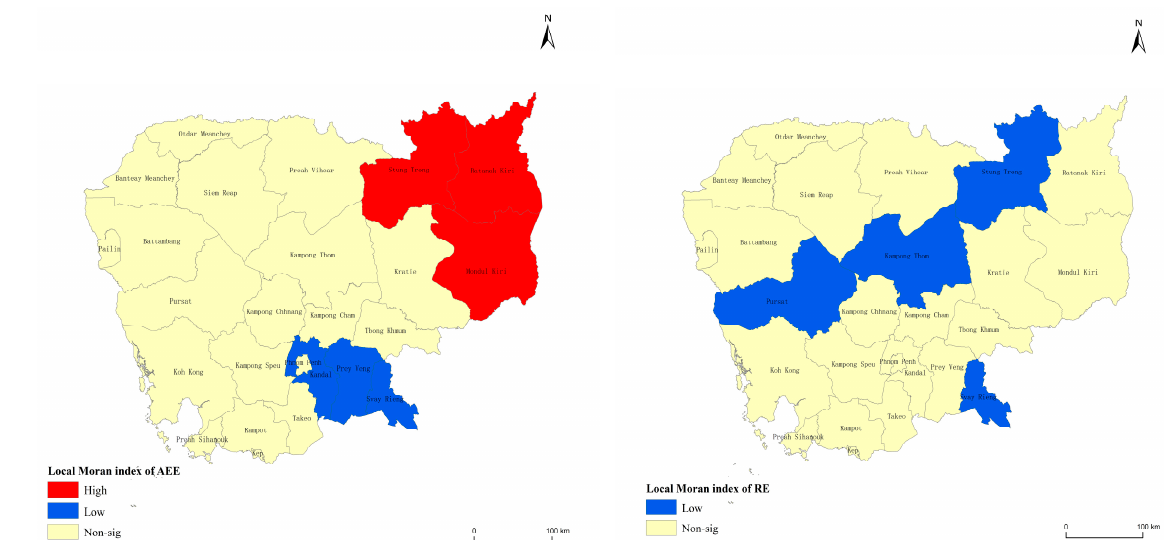
Figure 4. Aggregation analysis of agricultural eco-environment and road environment in Cambodia.